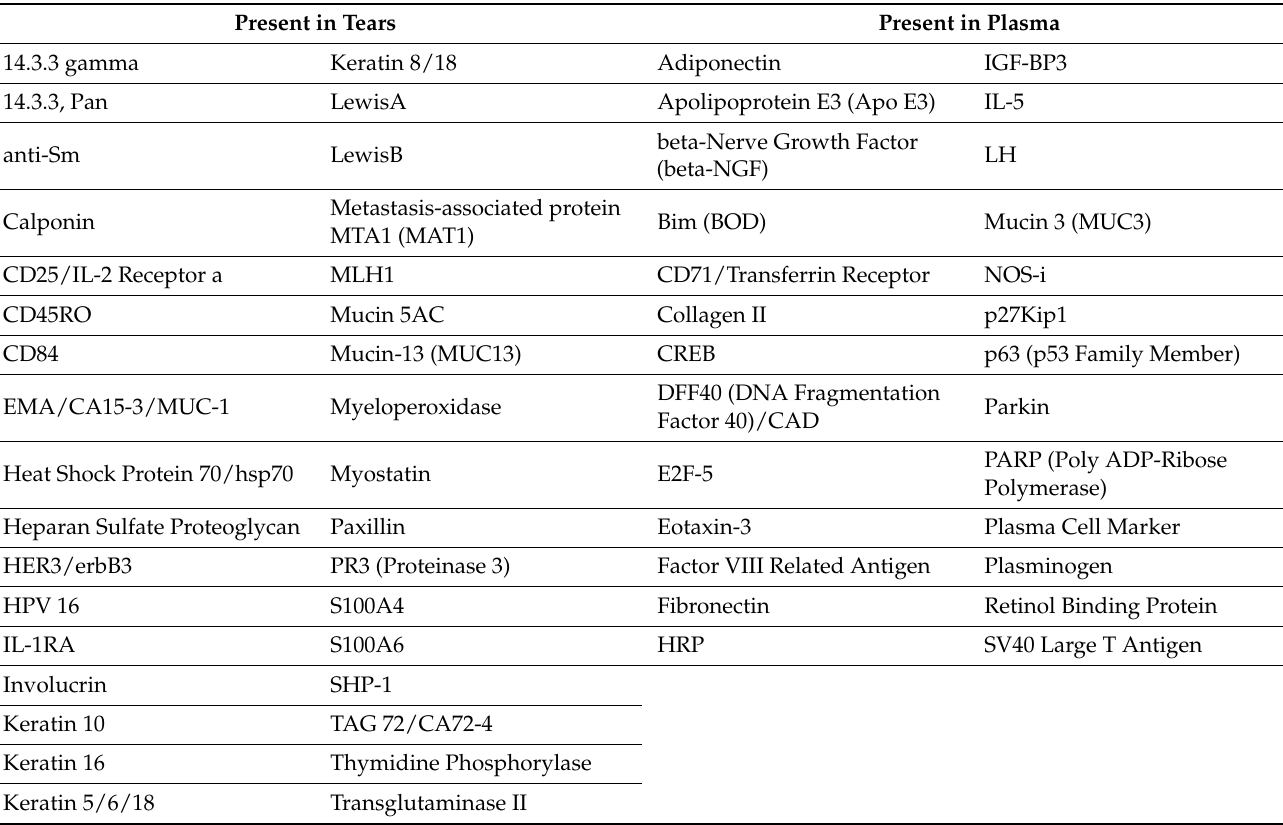
Table A1. List of proteins detected unique to tears and plasma